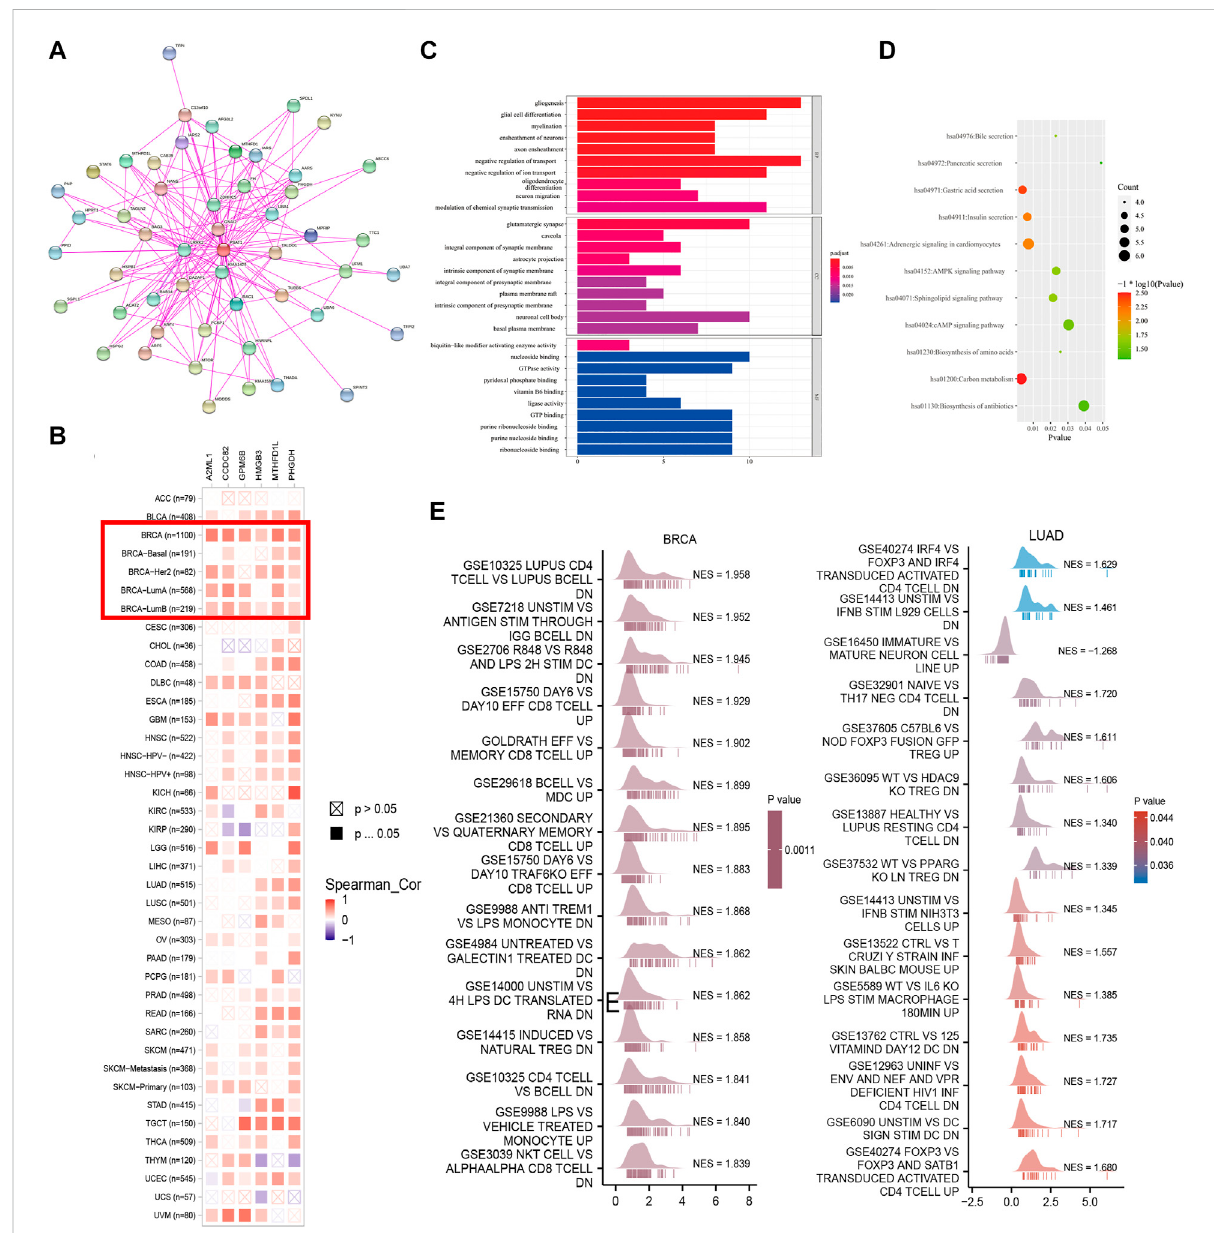
FIGURE 6 PSAT1-related gene enrichment analysis. (A) PSAT1-binding proteins were analyzed through an online tool String (B) The heatmap data of PSAT1relatedgenesintheTCGAprojectthroughGEPIA2weredisplayed (C) KEGGpathwayanalysiswasperformedbasedonthePSAT1-bindingand interacting genes (D) GO analysis for the molecular function. (E) GSEA analysis showing the enrichment of immune signal pathways in BRCA and